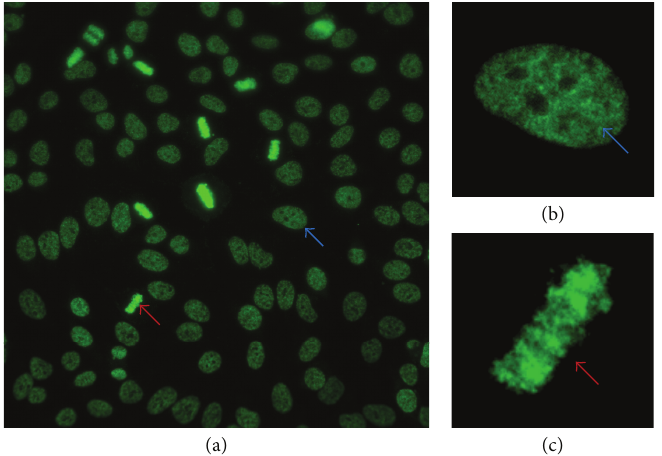
Figure 3: Characteristic staining pattern of anti-DFS70 antibodies. The characteristic dense fine speckled (DFS) staining pattern of interphase HEp-2 cells is indicated by the blue arrow and the strong chromatin staining of mitotic cells by the red arrow. (a) Wide field view using 40x magnification, (b) dense fine speckled pattern of an interphase nucleus, and (c) of the metaphase chromatin of a mitotic